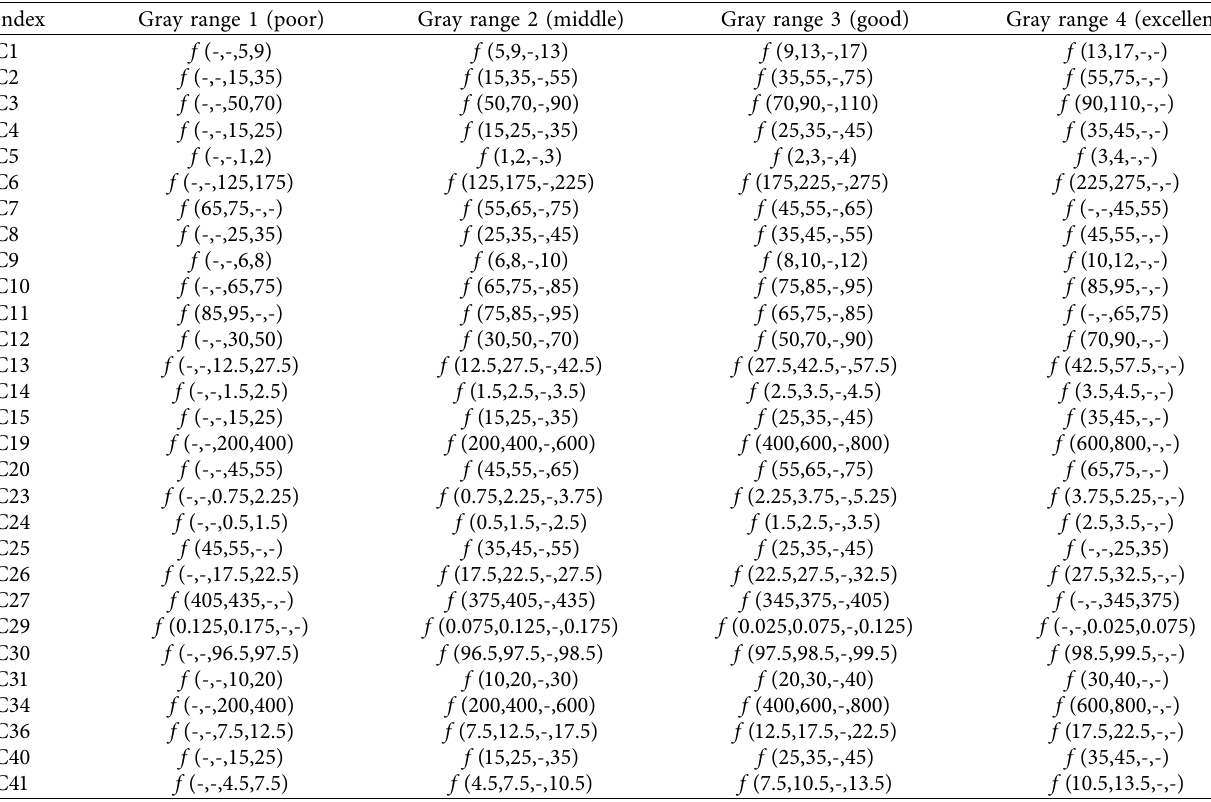
Table 4: Albino functions for each quantitative